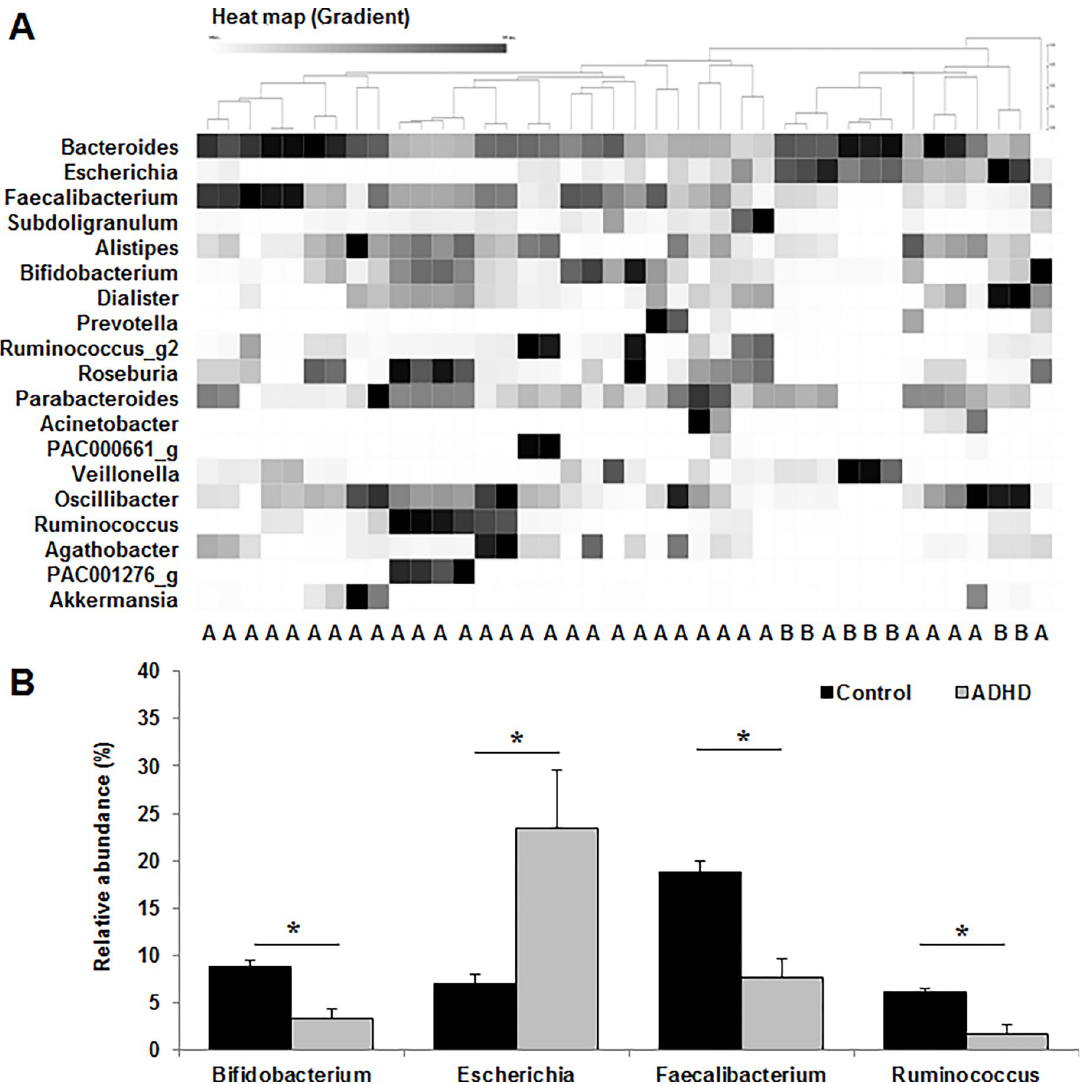
Fig 2. Comparison of the gut microbiota at the genus level between the control and attention deficit hyperactivity disorder (ADHD) groups. ( A ) Heat map of different genera in the gut microbiota. A, control group; B, ADHD group. ( B ) Relative abundance of the gut microbiota. Values are expressed as the mean ± SEM. The statistical significance between the control and ADHD groups was analyzed by the Student’s t-test ( � p <